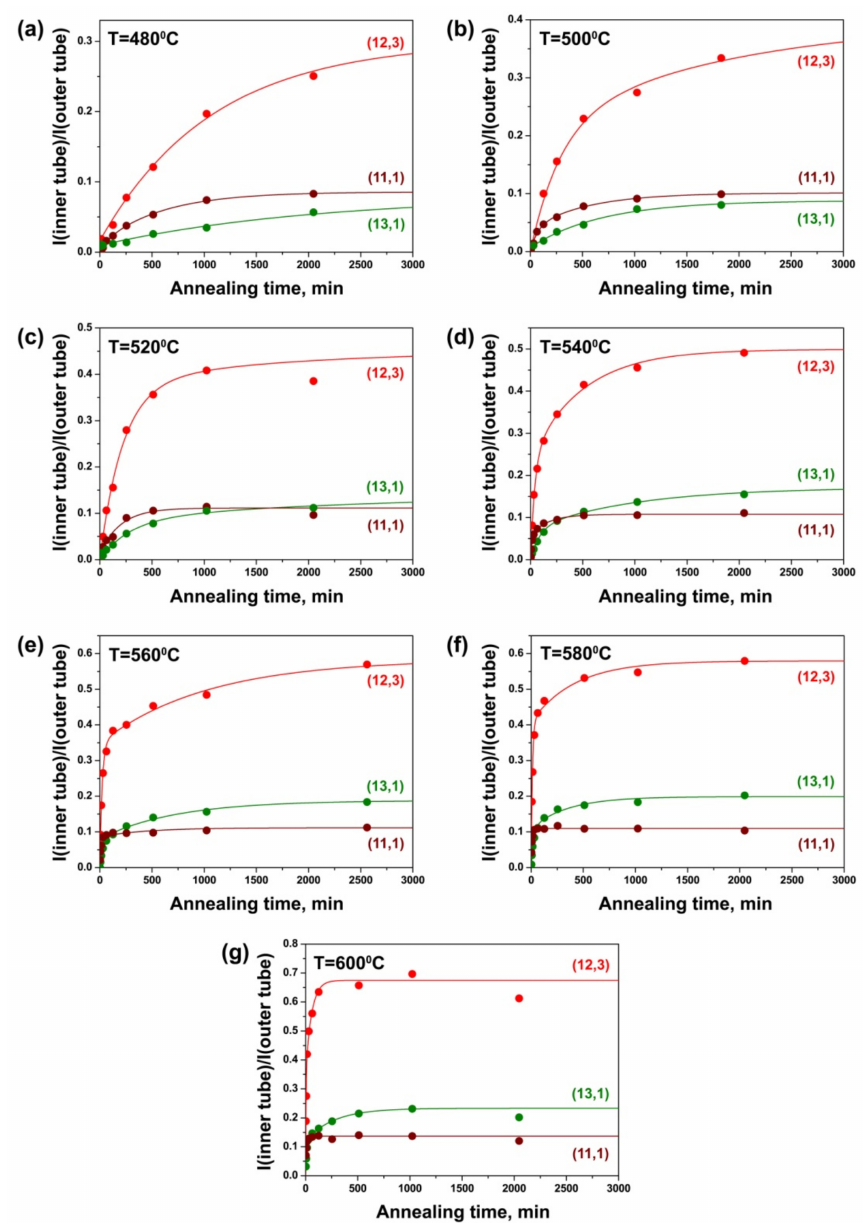
Figure 7. The integral intensity of peaks of the (12,3), (13,1) and (11,1) inner tubes normalized to the intensity of the outer tube peak observed in the RBM-band of Raman spectra of the annealed NiCp 2 -filled SWCNTs acquired at a laser wavelength of 633 nm (E ex = 1.96 eV) plotted versus annealing time. The experimental data for the samples annealed at temperatures of 480 ◦ C ( a ), 500 ◦ C ( b ), 520 ◦ C ( c ), 540 ◦ C ( d ), 560 ◦ C ( e ), 580 ◦ C ( f ) and 600 ◦ C ( g ) are shown as filled circles. The fitting results of the data are presented as solid